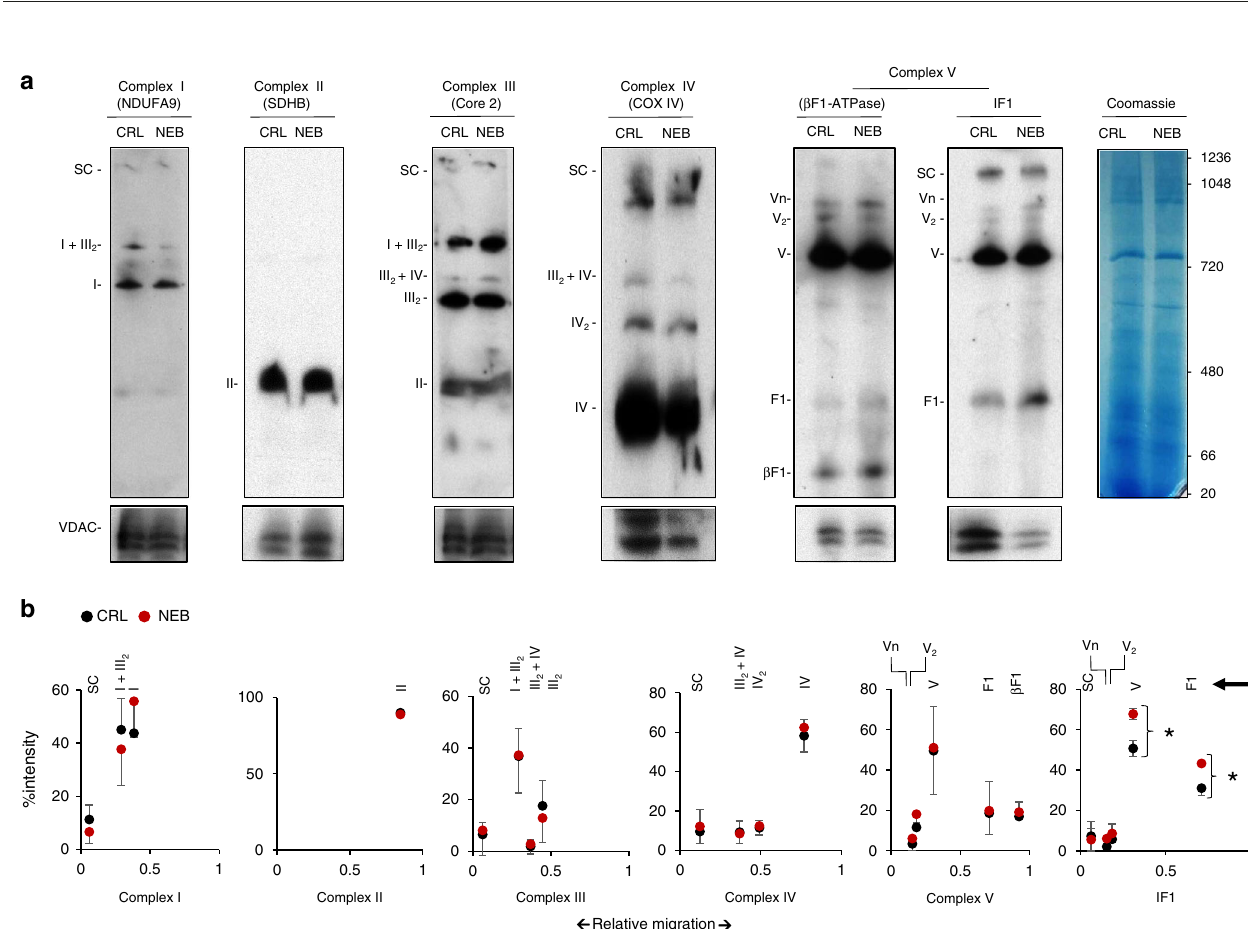
Fig. 2 Nebivolol inhibits mitochondrial ATP synthase. HCT116 and MDA-MB-231 cells were treated during 3 h with 1 µ M nebivolol (NEB; red dots and bars), oligomycin (OL; gray dots and bars) or left untreated (CRL; closed dots or bars). a Left panel, kinetic representation of the production of ATP in digitonin-permeabilized cells. The inhibition of ATP synthase activity was accomplished by the addition of 30 μ M OL. Right panel, histograms show the ATP synthetic activity. Six replicates of six (HCT116, ** p = 0.001 and ** p = 0.00001) and three (MDA-MB-231, ** p = 0.004 and ** p = 0001) different biological samples are shown. b Glycolytic fl ux measured by the initial rates of lactate production. Three replicates of three different biological HCT116 (* p = 0.01 and 0.01) and MDA-MB-231 (* p = 0.04 and p = 0.01) samples are shown. c Plots and histograms of TMRM + stained cells to assess the mitochondria membrane potential ( ΔΨ m). FCCP (orange) collapses ΔΨ m. Three replicates of three different biological HCT116 (* p = 0.01 and 0.01) and MDA-MB-231 (* p = 0.05 and 0.02) samples are shown. See Supplementary Fig. 7a for gating strategy. d Histograms show ROS production in HCT116 (* p = 0.02) and MDA-MB-231 (* p = 0.05) cells treated (red) or not (black) for 3 h with 1 µ M nebivolol. Three replicates of three different biological samples are shown. See Supplementary Fig. 7b for gating strategy. e Representative western blots of four different biological samples of the expression of mitochondrial proteins from complex I (NDUFA9), complex II (SDHB), complex III (Core 2), complex IV (COX IV), complex V ( β -F1-ATPase) and IF1 (* p = 0.011 and 0.02), Hsp60 and GAPDH and tubulin as loading controls. Two different samples of control (CRL; closed bars) and nebivolol-treated (NEB; red bars) cells are shown. Bars indicate the mean ± SEM of the indicated samples. * p < 0.05 and ** p < 0.01 when compared to CRL by two-sided Student ’ s t test. See also Supplementary Fig. 2. Source data are provided as a Source Data fi le.